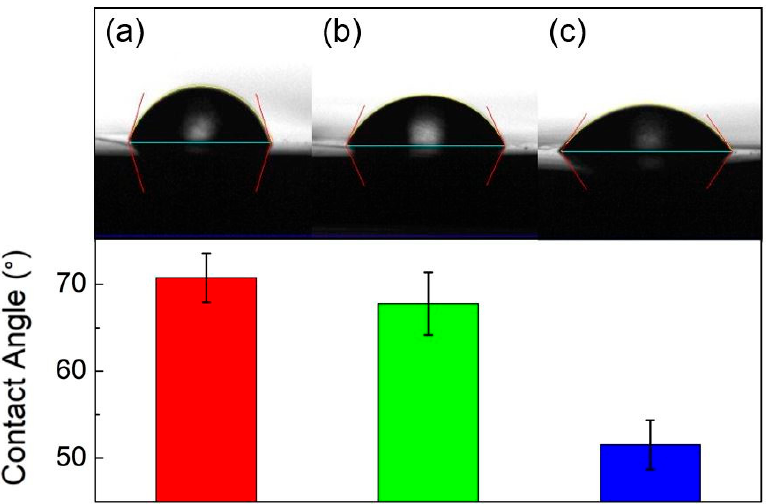
Figure 6. Contact angle of ( a ) Au/ZnPP electrode (w/o LT) and ( b ) Au/ZnPP/Avastin electrode (w/o LT), which were kept under dark conditions for 10 min, and ( c ) Au/ZnPP/Avastin electrode (w/LT), which was exposed to white light of 1200 lm for 10 min. Bars indicate the mean contact angle values ( n = 9).